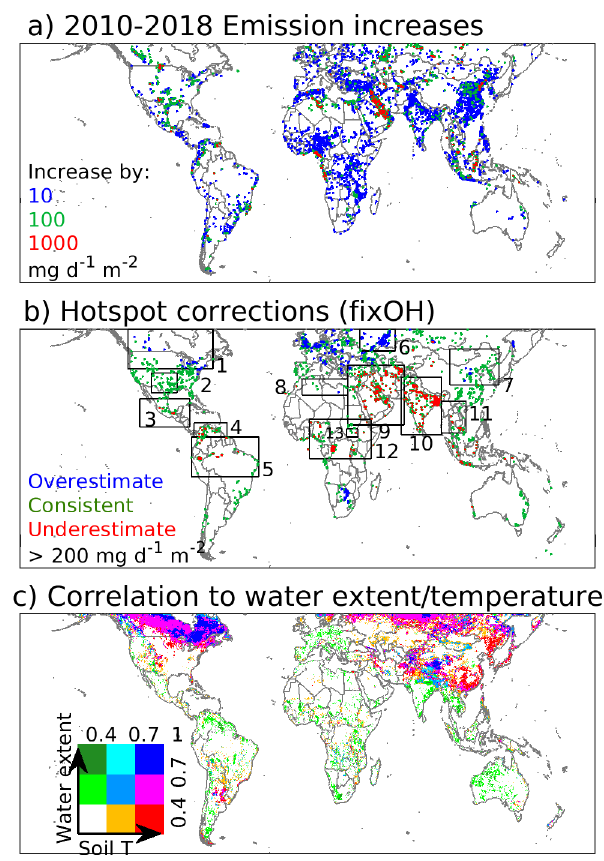
Figure 5. (a) Methane emission increases during 2010– 2018 estimated from bottom-up information (EDGAR v6, 2022). (b) Methane source hotspots ( > 200kgd − 1 km − 2 ) and their TROPOMI-derived emission corrections (blue: > 30% over- estimate; green: accurate to ± 30%; red: > 30% underestimate). (c) Correlations between the optimized wetland emissions, soil tem- perature (0–7cm; ERA5 2019), and surface water extent (Jensen et al.,